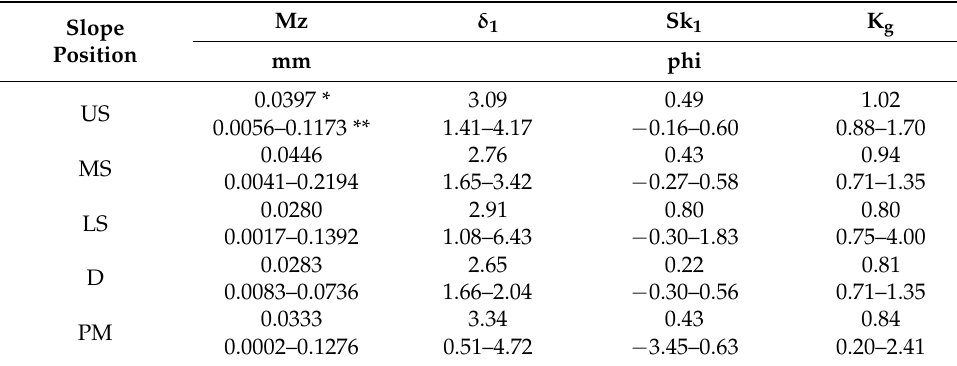
Table 5. Sedimentological indices in humus horizons and parent materials in moraine landscape, regarding the soil position at the